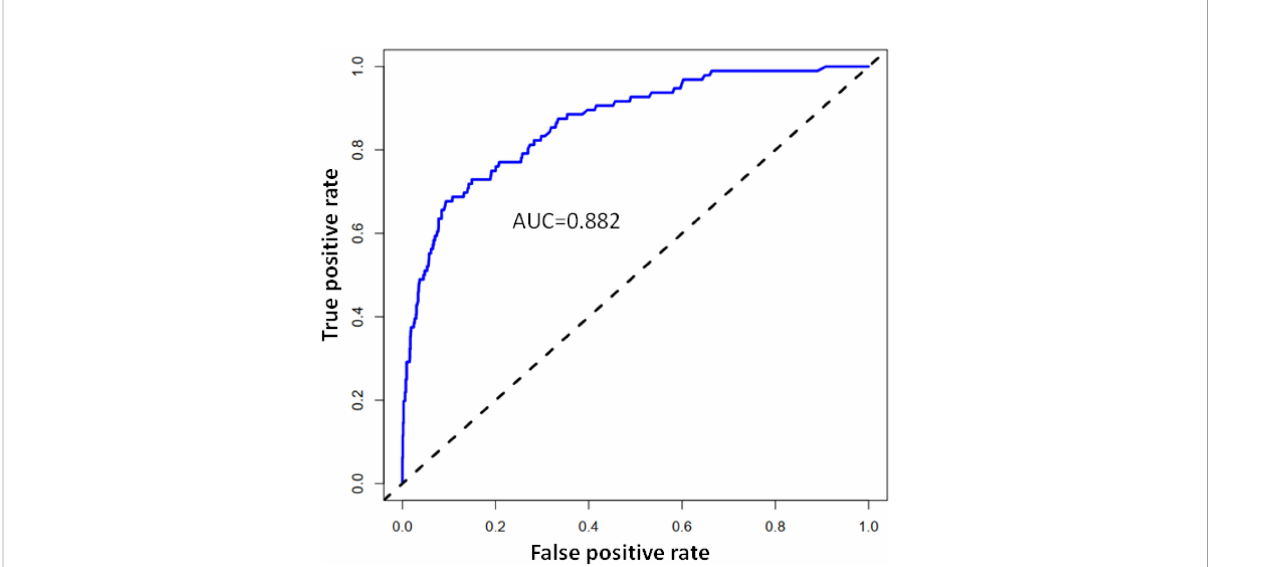
FIGURE 3 Calibration curve of the predictive value of the PMCC nomogram. The X-axis represents predicted PMCC risk and Y-axis represents actually diagnosed risk of PMCC. The diagonal dotted line represents the perfect prediction of the ideal model. The solid line represents the performance of nomogram (speci fi cally, the closer to the imaginary diagonal line, the better the prediction effect).